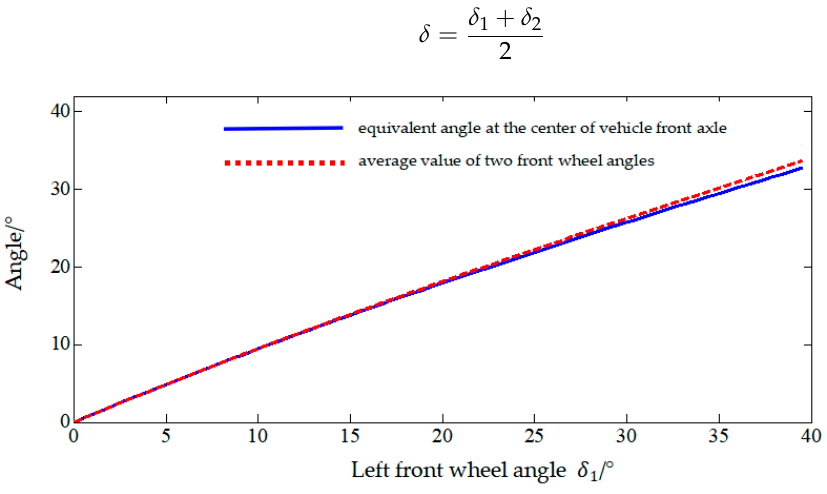
Figure 5. Relationship between equivalent angle at the center of vehicle front axle and average value of two front wheel angles.